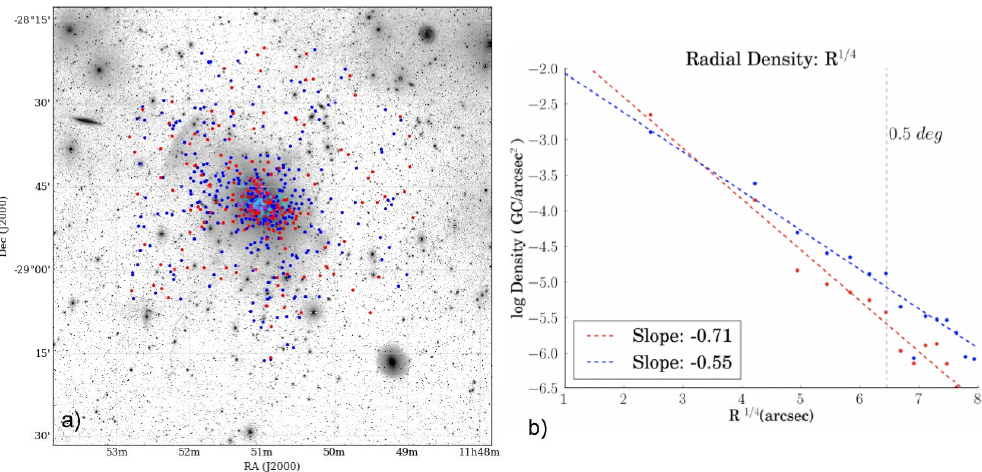
Figure 4. ( a ) Dark Energy Camera (DECam) g (cid:48) -band image with GC candidates indicated. Magenta and cyan points are GC candidates from [13], while the red and blue points are DECam detections. Magenta and red points indicate indicate the “red” objects with ( g (cid:48) − i (cid:48) ) ≥ 0.85, while cyan and blue points are for “blue” objects with ( g (cid:48) − i (cid:48) ) < 0.85. ( b ) The radial distributions of the “red” and “blue” GC candidates as separated in panel a). As in other galaxies, the bluer GC candidates have a more extended